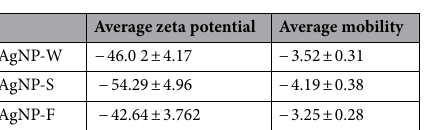
Table 1. Average zeta potential and mobility of AgNP-W, AgNP-S and